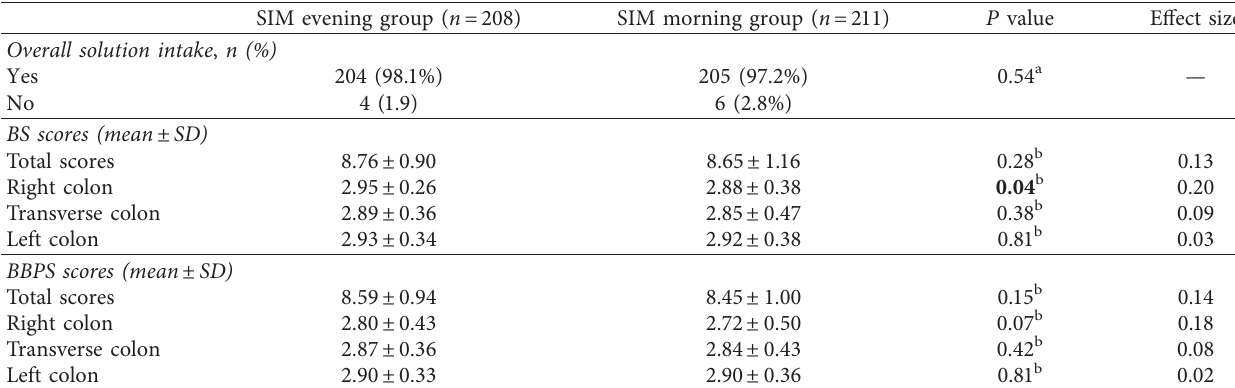
Table 2: BS and BBPS scores.